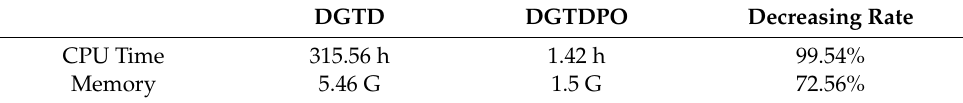
Table 5. The CPU time and memory of DGTD and DGTDPO for multi scale-plate composite objects. DGTD DGTDPO Decreasing Rate